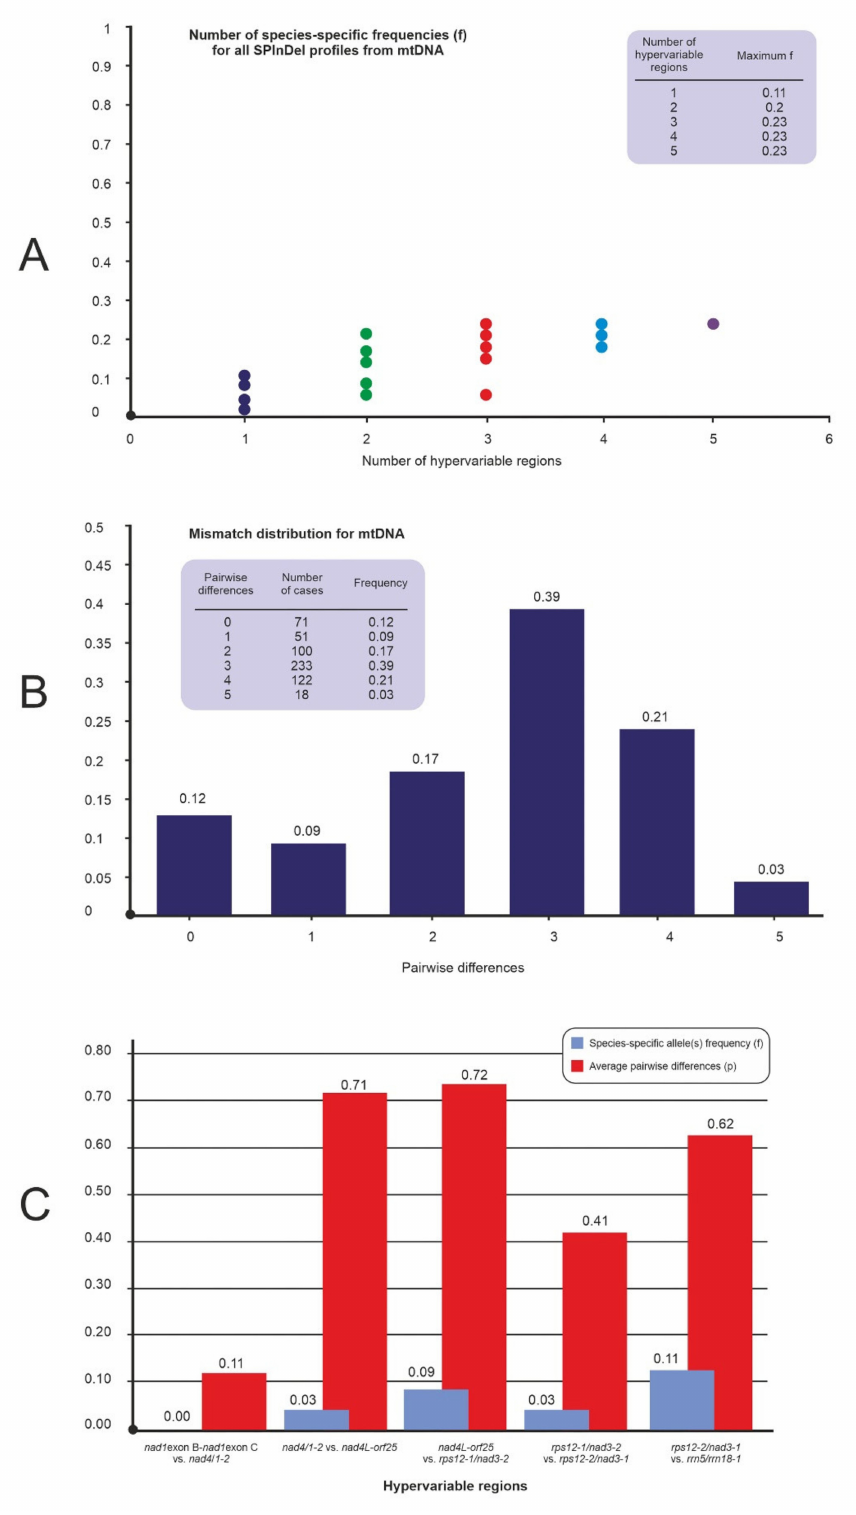
Figure 3. SPInDel analysis of 6 mtDNA noncoding regions; ( A ) The frequency of species-specific profiles in all combinations of hypervariable mtDNA regions; ( B ) Mismatch distribution, i.e., the frequency distribution of the number of SPInDel hypervariable mtDNA regions that di ff er between all pairs of SPInDel profiles in a taxonomic group; ( C ) The discriminatory potential of each hypervariable mtDNA region individually (region by region